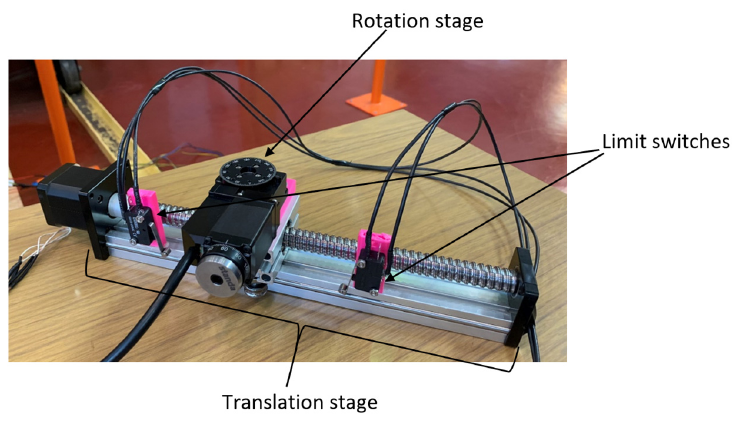
Figure 8. Neutron tomography setup.